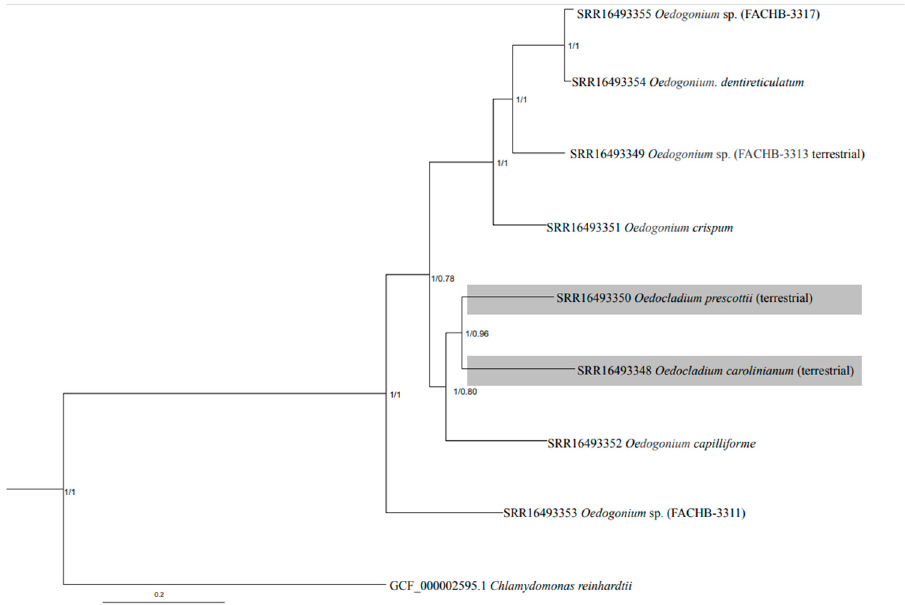
Figure 1. Phylogenetic tree of the Oedogoniales species based on 99 single-copy orthogroups by Mrbayes and ASTRAL. Numbers on branches represent support values of ASTRAL and Bayesian posterior probabilities respectively. Branch lengths are proportional to genetic distances, which are indicated by the scale bar. The grey background indicates the Oedocladium species.